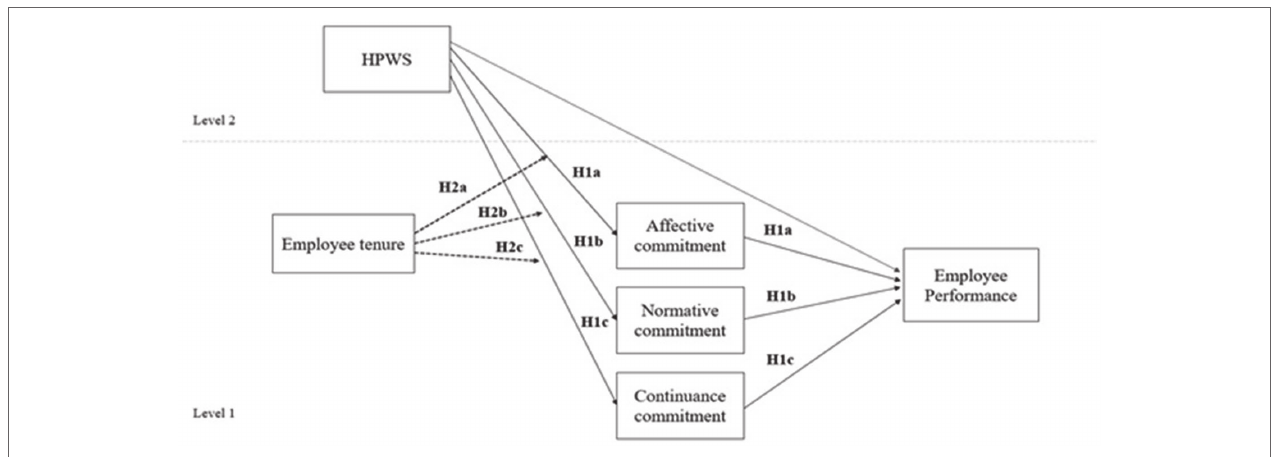
FIGURE 1 | Conceptual